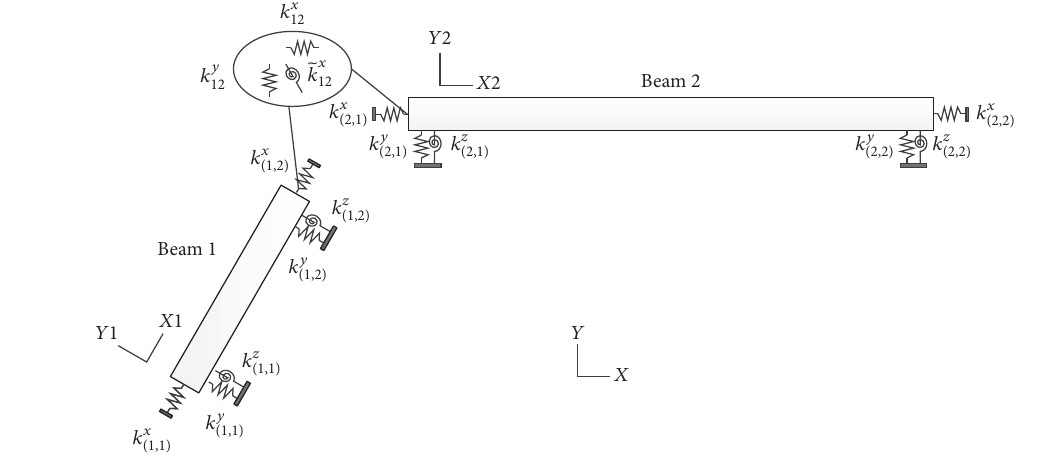
Figure 1: An illustration of a coupled beams system. Table 1: The form of